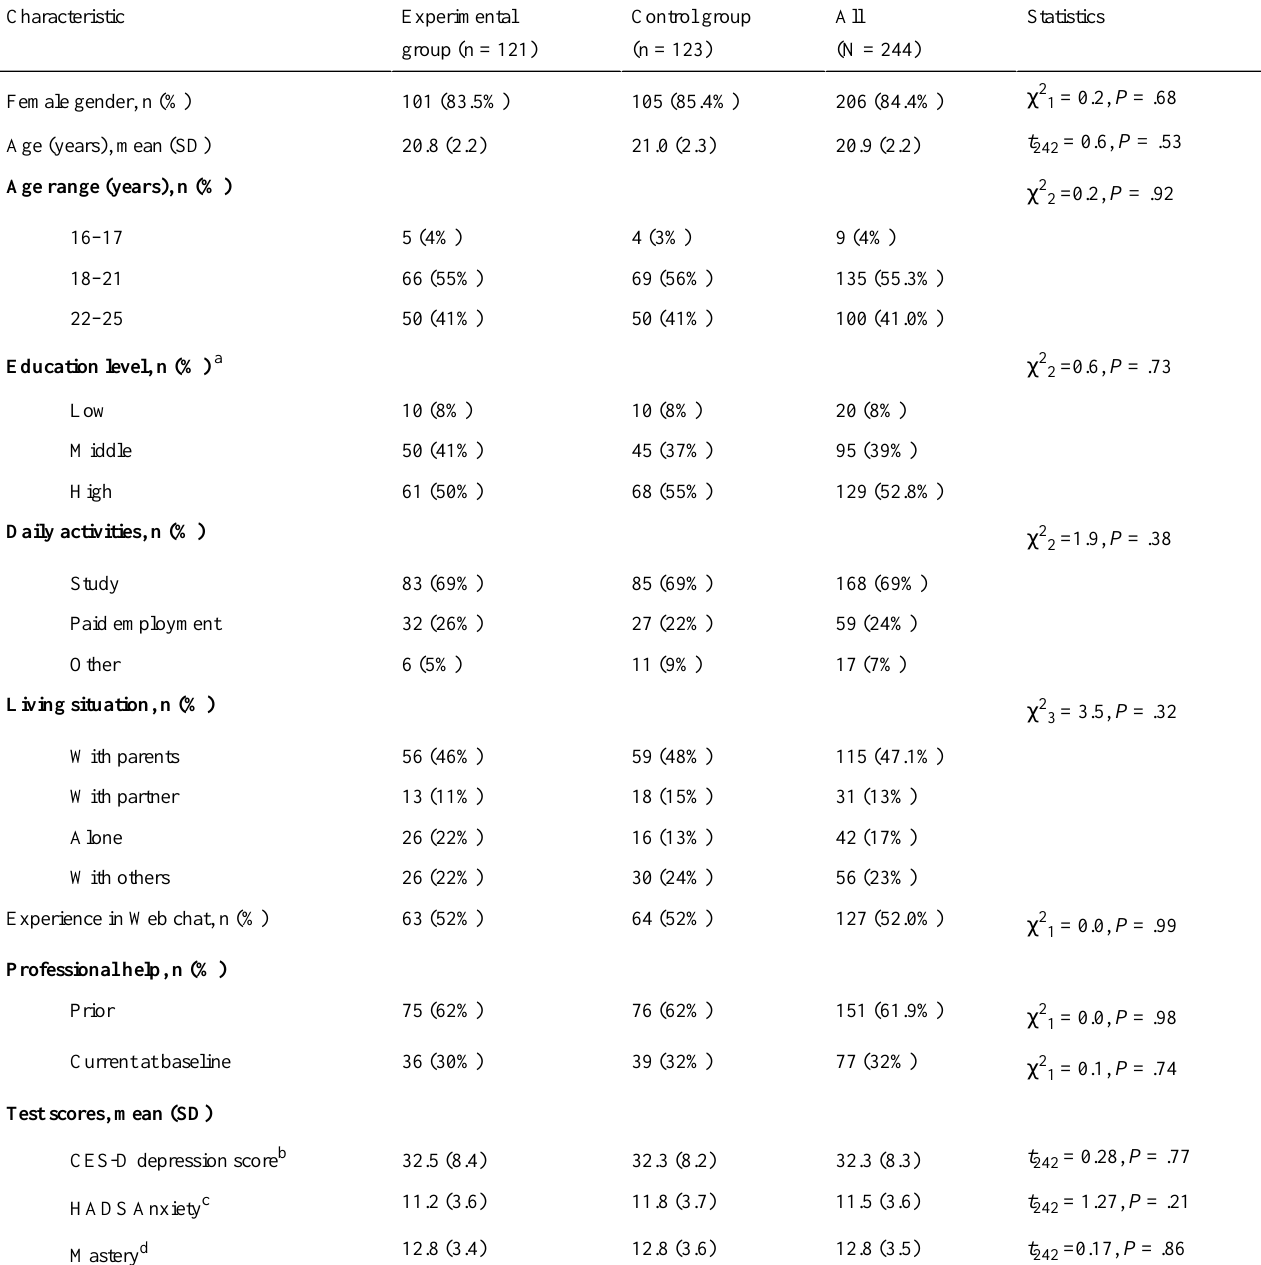
Table 2. Baseline characteristics of the 244